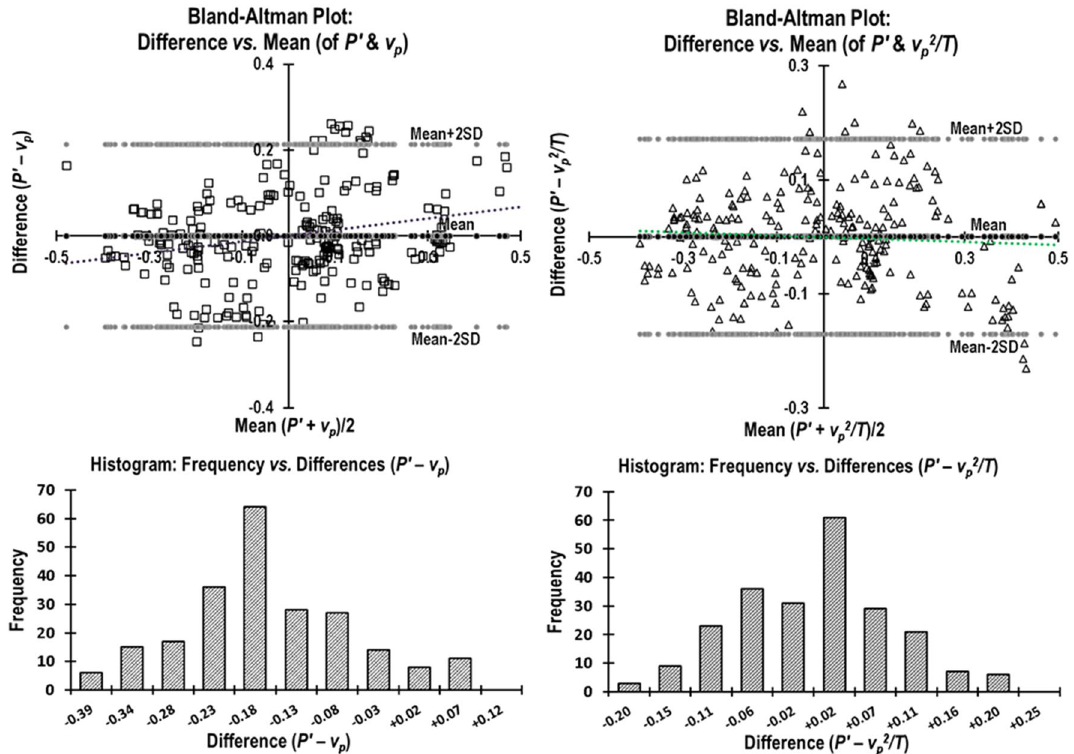
Figure 6. ( A ) Normalized Bland–Altman plot of the agreement between + dP/dtmax ( P ′ ) and peak aortic acceleration (v ′ p ). Plot of Difference ( P ′ – v ′ p ) versus Mean ½ ( P ′ + v ′ p ) along with the histogram distribution of the differences. ( B ) Normalized Bland–Altman plot of the agreement between + dP/dtmax ( P ′ ) and mean aortic acceleration ( v ′ m ). Plot of Difference ( P ′ – v ′ m ) versus Mean ½ ( P ′ + v ′ m ) along with the histogram distribution of the differences.